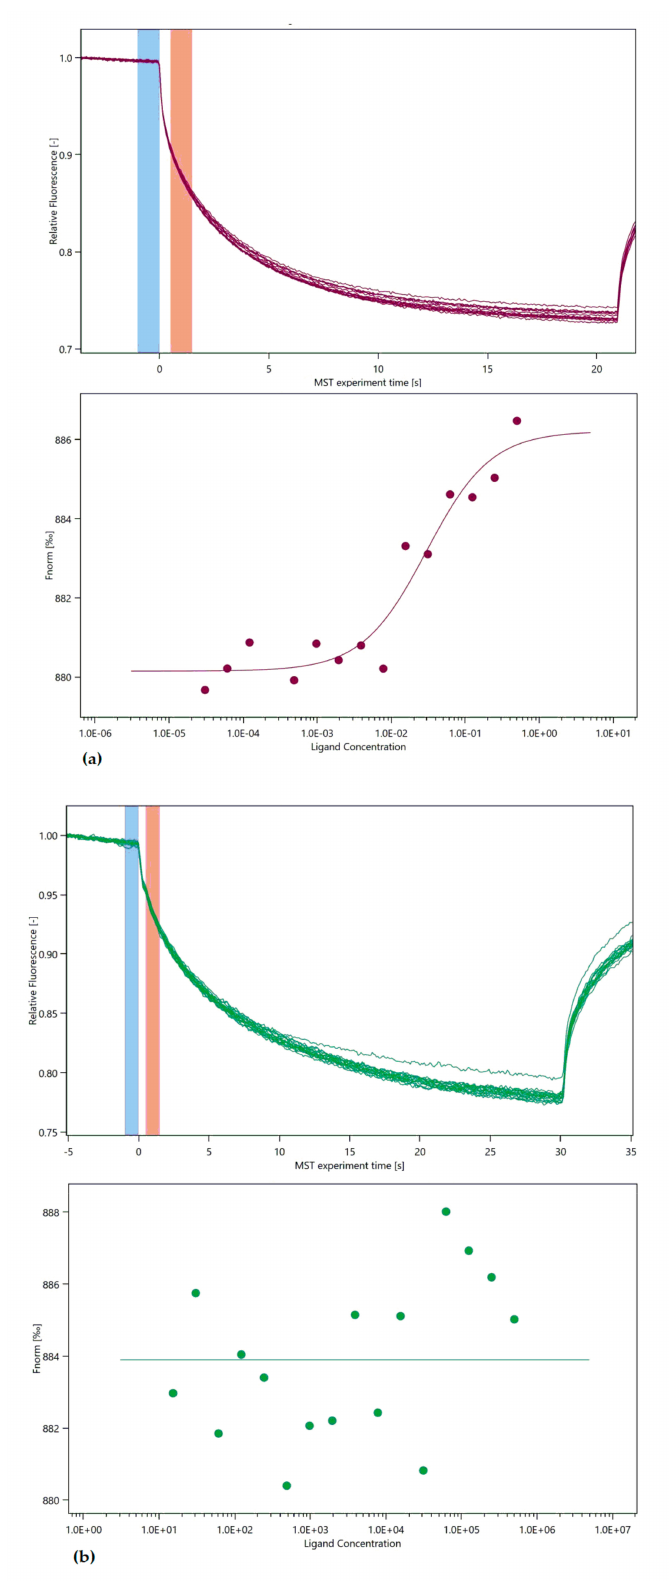
Figure 2. ( a ) the binding of fluorescently labelled protein to affected lnc -EPB41-1-1 is analysed with microscale thermophoresis (MST). RNA was titrated and change in the thermophoretic signal leads to binding affinity of 30 nM ± 11.6 nM with S/N: 10; ( b ) the interaction of labelled protein with wild type lnc -EPB41-1-1 is measured and MST showed no/weak binding under the tested